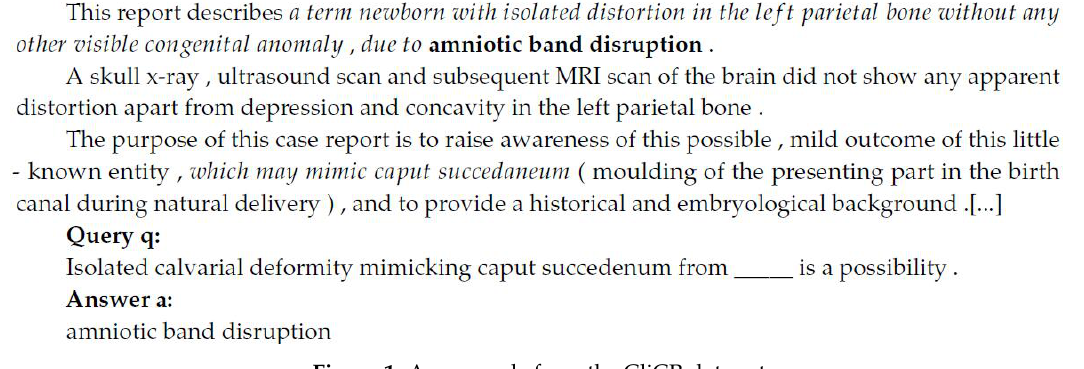
Figure 1. An example from the CliCR data